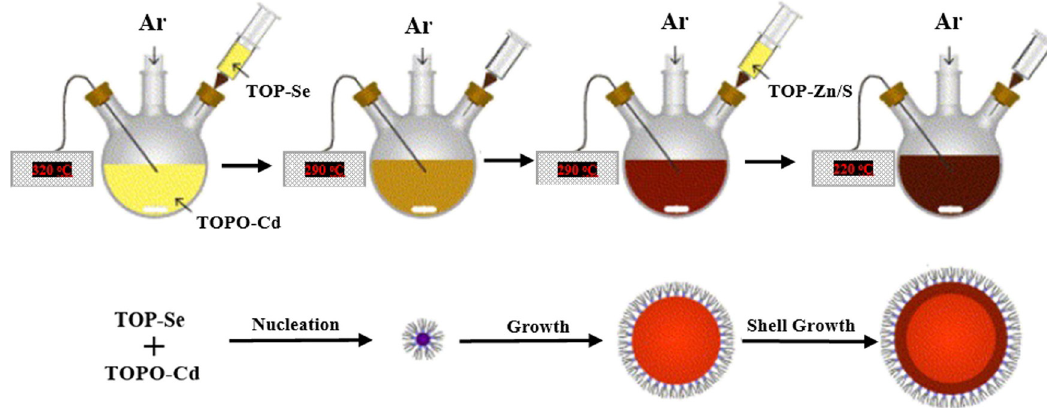
Figure 9: Colloidal synthesis of CdSe ( where trioctylphosphine ( TOP ) , trioctylphosphine oxide ( TOPO )) [ 27 ]